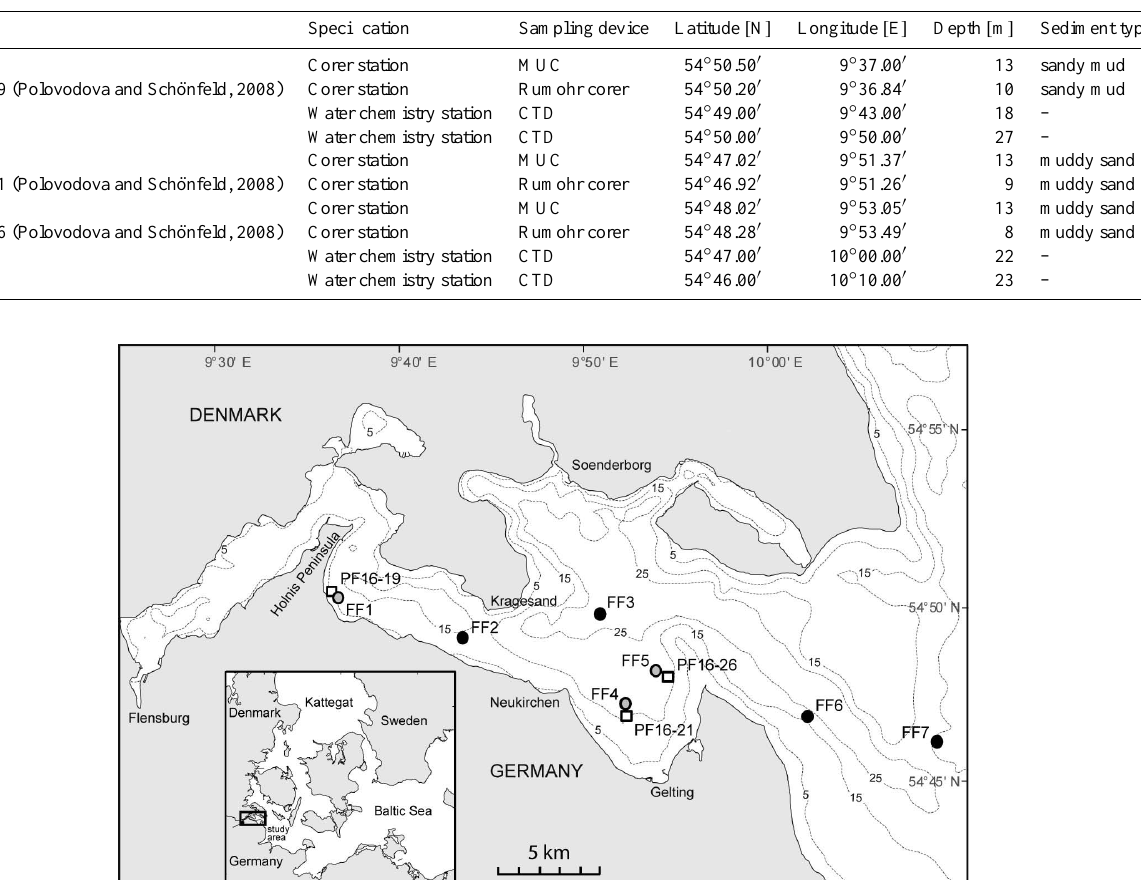
Table 1. Sampling stations in Flensburg Fjord: specification, sampling device, latitude and longitude, water depth in metre, and sediment type at the corer stations (FF1, FF4 and FF5).